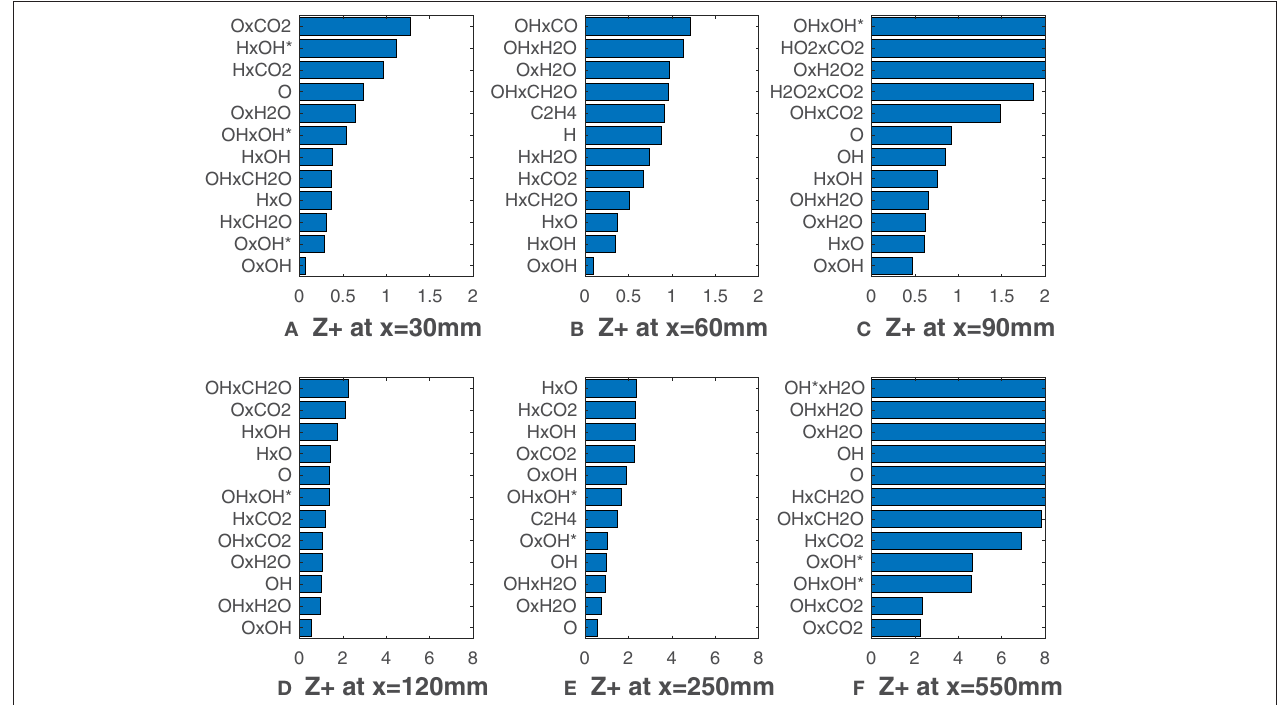
FIGURE 7 | HM1 case: best correlated markers at various axial locations. Lower Z + s ( ν ) values mean better correlation. Here ν comprehends both X α and their combinations.